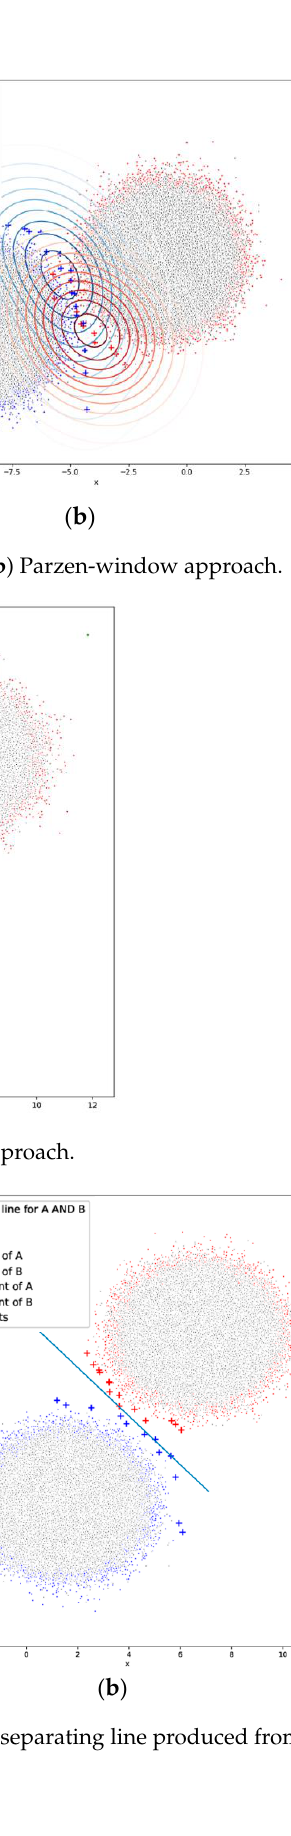
Figure 8. ( a ) Skyline points in comparison to the SVM points; ( b ) separating line produced from both